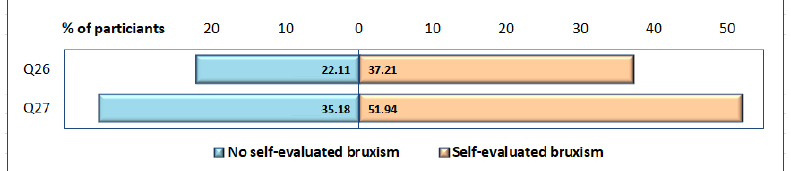
Figure 4. Distribution of participants (expressed as percentage) presenting clinical signs of anxiety: panic [Q26], restlessness [Q27].